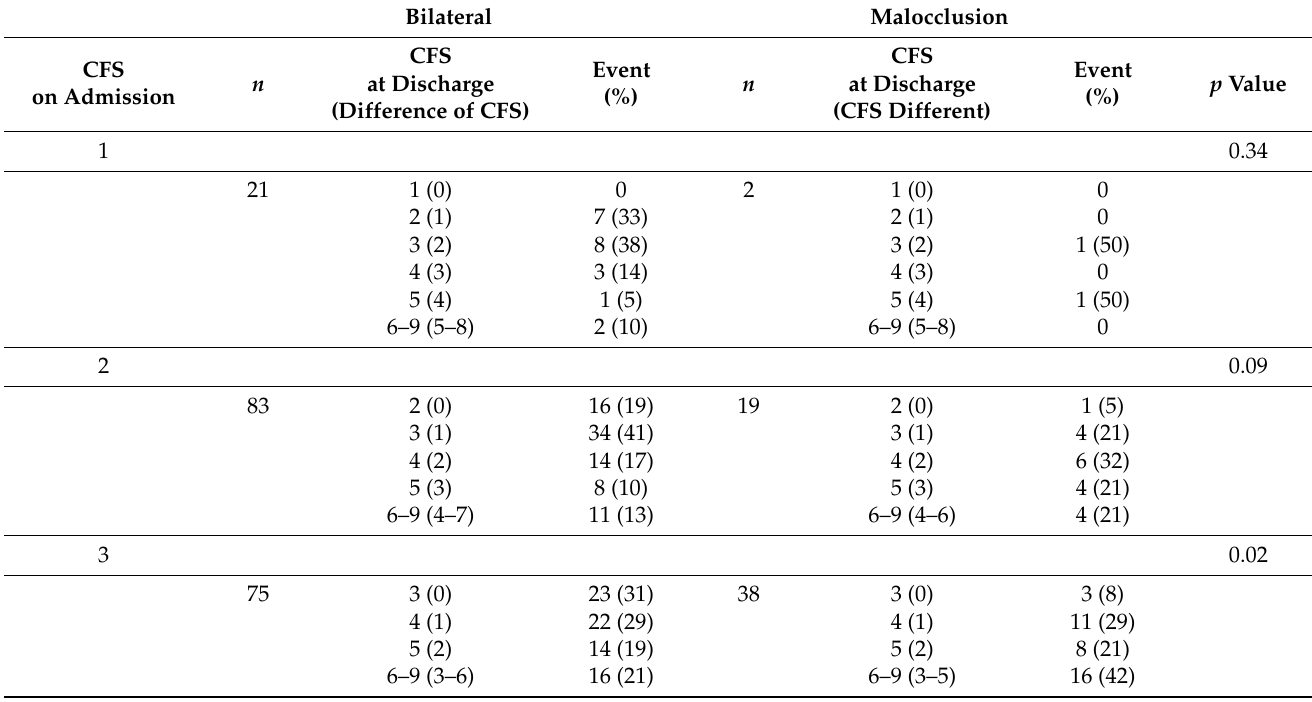
Table A2. Subgroup analysis by stratifying the level of CFS at admission to observe the difference of CFS in each level of